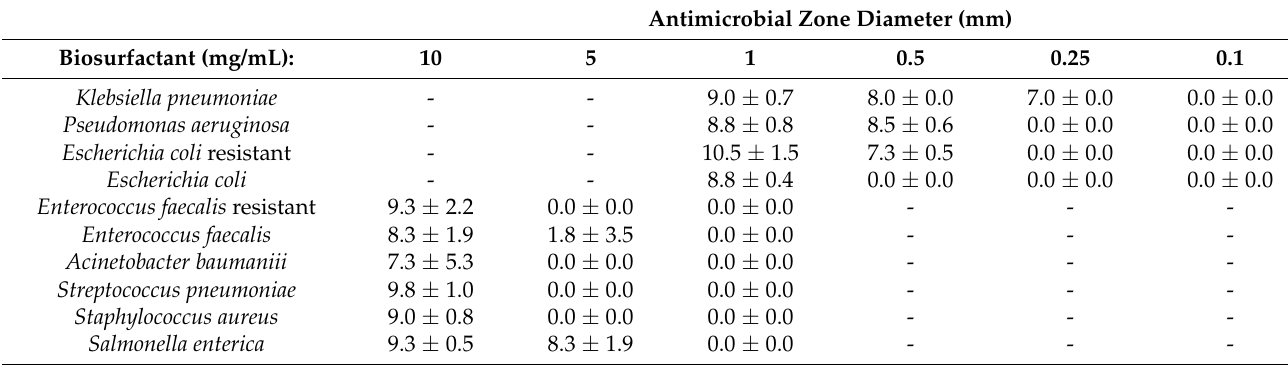
Antimicrobial Zone Diameter (mm)